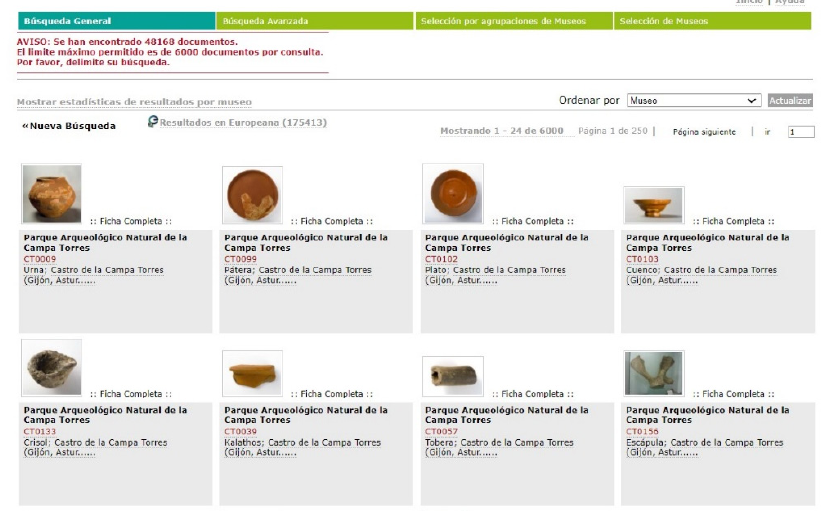
Figure 1. A search for “cerámica” on the CER.ES website.